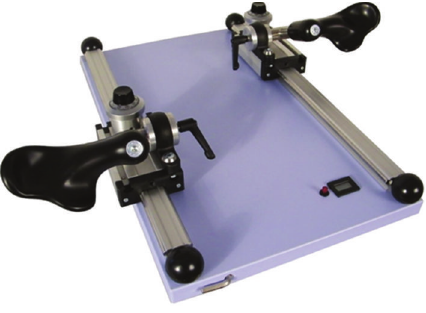
Figure 3: Reha-Slide Duo. Reprinted with permission (http://www